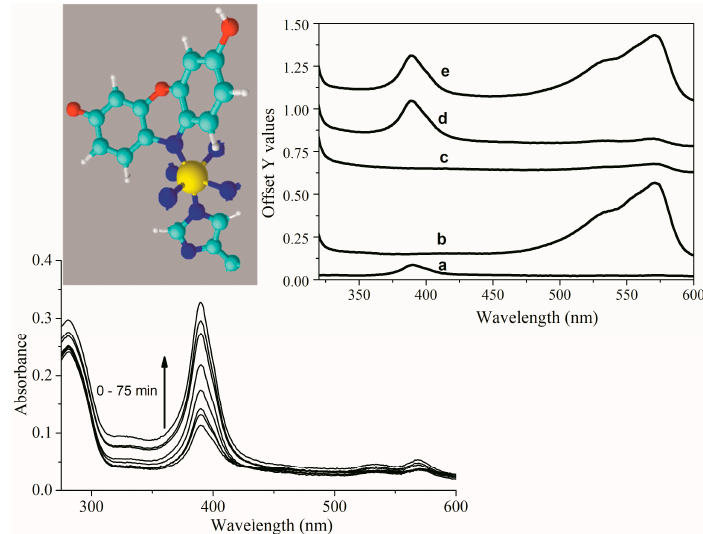
Figure 9. Reaction of the hydrogen peroxide-activated Cu(II)MP-11 with Amplex Red. Time scan in the time range of 0–75 min of 0.5 µM Cu(II)MP-11 after addition of 40 µM Amplex Red and hydrogen peroxide, as indicated by the arrow. The inset shows the spectra of: ( a ) 0.5 µM Cu(II)MP-11; ( b ) Resofurin produced by 25 nM HRP activated by 40 µM hydrogen peroxide; ( c ) Leucoresofurin produced by resofurin reduction by superoxide ion generated by xanthine/xanthine oxidase system in the presence of 25 nM catalase used to eliminate hydrogen peroxide produced by spontaneous ion superoxide dismutation; ( d ) Cu(II)MP-11 added to leucoresofurin solution; ( e ) the same conditions of ( d ) reoxygenation after agitation. Another inset shows the structural representation of dihydroresofurin in a putative coordination with Cu(II) in the porphyrin ring. Only nitrogen atoms of the porphyrin ring were represented for clarity. In the 3D structure, carbons are cyan, nitrogens are blue, copper is yellow and oxygen is red. MP-11 histidine residue was represented at the fifth coordination position of cupper ion. Xanthine concentration was 400 µM and xanthine oxidase 0.6 U/mL. Differently from Fe(III)MP-11, the spectrum of resofurin with peak at 571 nm did not appear during the incubation of the copper heme peptide with hydrogen peroxide and Amplex Red. In addition, a time- dependent increase of Cu(II)MP-11 Soret and Q bands during the reaction with Amplex Red was